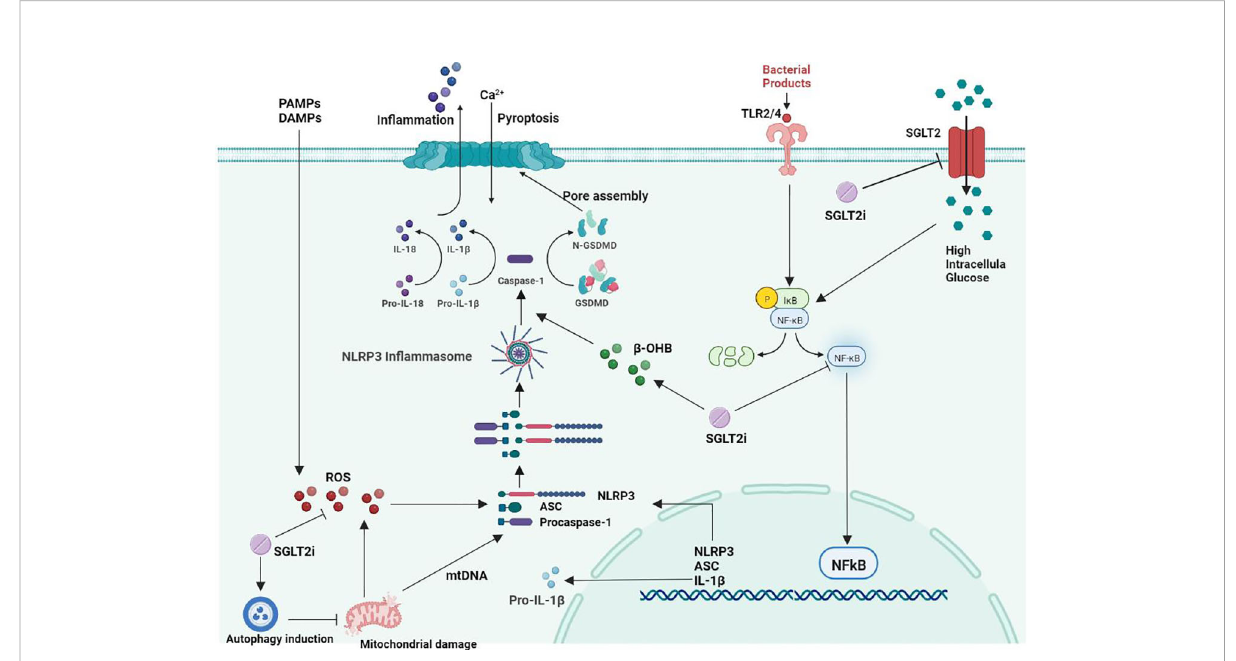
FIGURE 1 Mechanism of the effect of SGLT2 inhibitors on NLRP3 in fl ammatory vesicles in